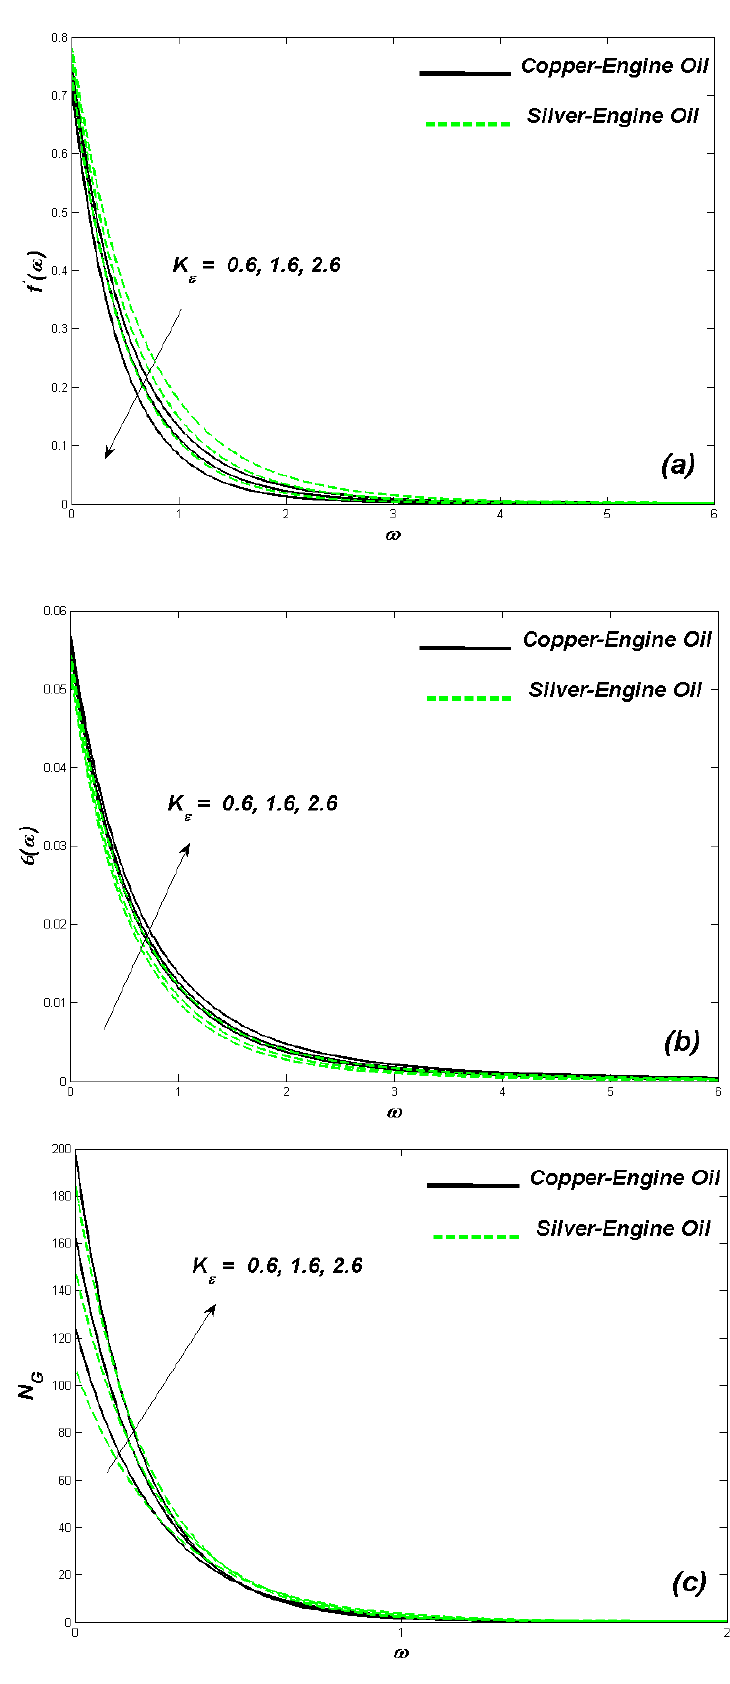
Figure 4. ( a ) Velocity change with K ε . ( b ) Temperature change with K ε . ( c ) Entropy change with K ε